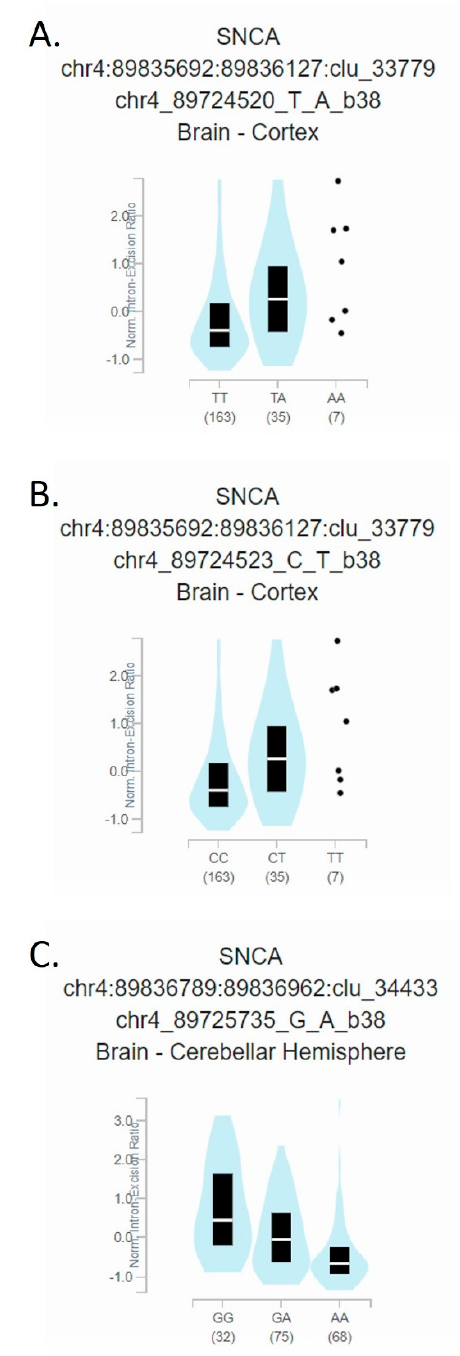
Figure 3. Figure is processed from GTeX (https://www.gtexportal.org; accessed at 26 September 2021 Data Source: GTEx Analysis Release V8 (dbGaP Accession phs000424.v8.p2)), and represent the splicing quantitative trait locus (sQTL) effects of: ( A ). rs1045722 in the 3 ′ UTR of SNCA and ( B ). rs3857053 in the 3 ′ UTR of SNCA in cortex and ( C ). rs356165 in the 3 ′ UTR of SNCA cerebral hemisphere.